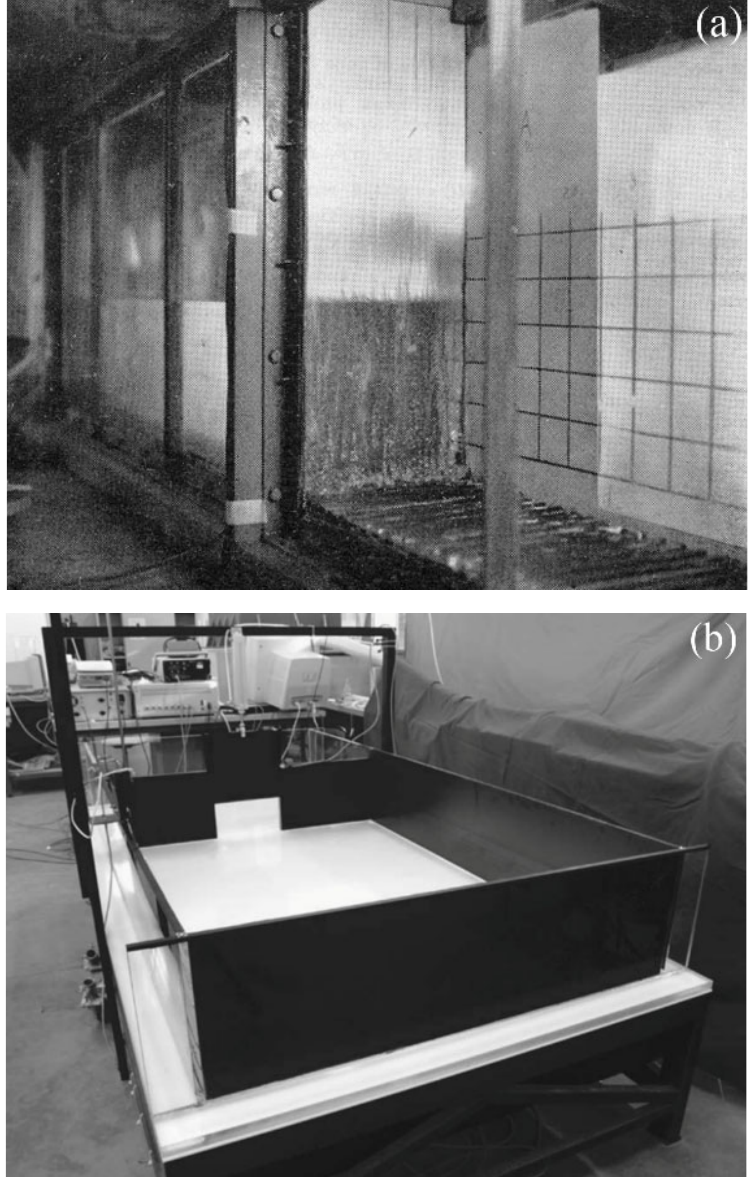
Figure 1. Pictures of typical experimental facilities for dam-break flow investigations. ( a ) Total dam- break in a rectangular channel (reprinted with permission from Ref. [13]; courtesy of International Association of Hydrological Sciences). ( b ) Partial dam-break in a prismatic tank (reprinted with permission from Ref. [14]).